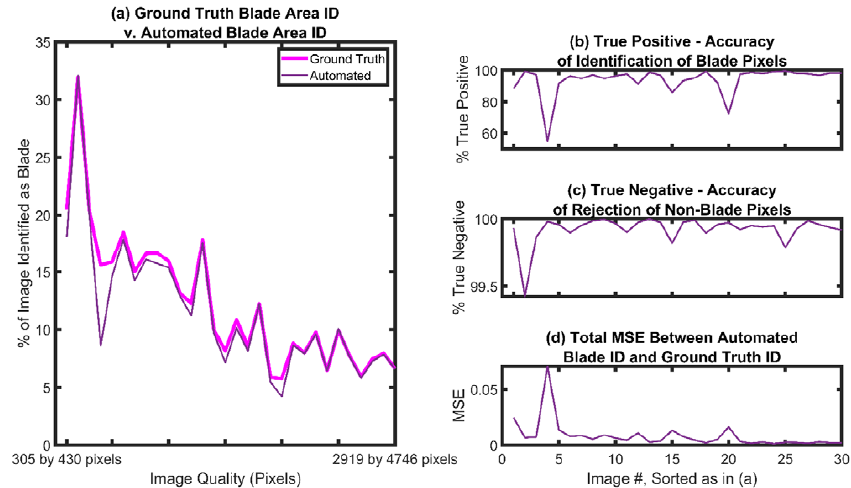
Figure 7. ( a ) Automated blade area quantification algorithm results (purple) compared to subjective (ground-truth) blade area (magenta). ( b ) Accuracy of automated identi fi cation of blade pixels com- pared to the ground-truth. ( c ) Accuracy of rejection of non-blade pixels compared to subjective iden- ti fi cation (higher accuracy denotes fewer false positives in pixels assigned to the blade class, i.e., less noise). ( d ) Total mean square error between automated and subjective blade pixel identi fi cation. Table 5. Accuracy of the three tasks (blade area quanti fi cation, damage quanti fi cation, damage clas- si fi cation) for each method.